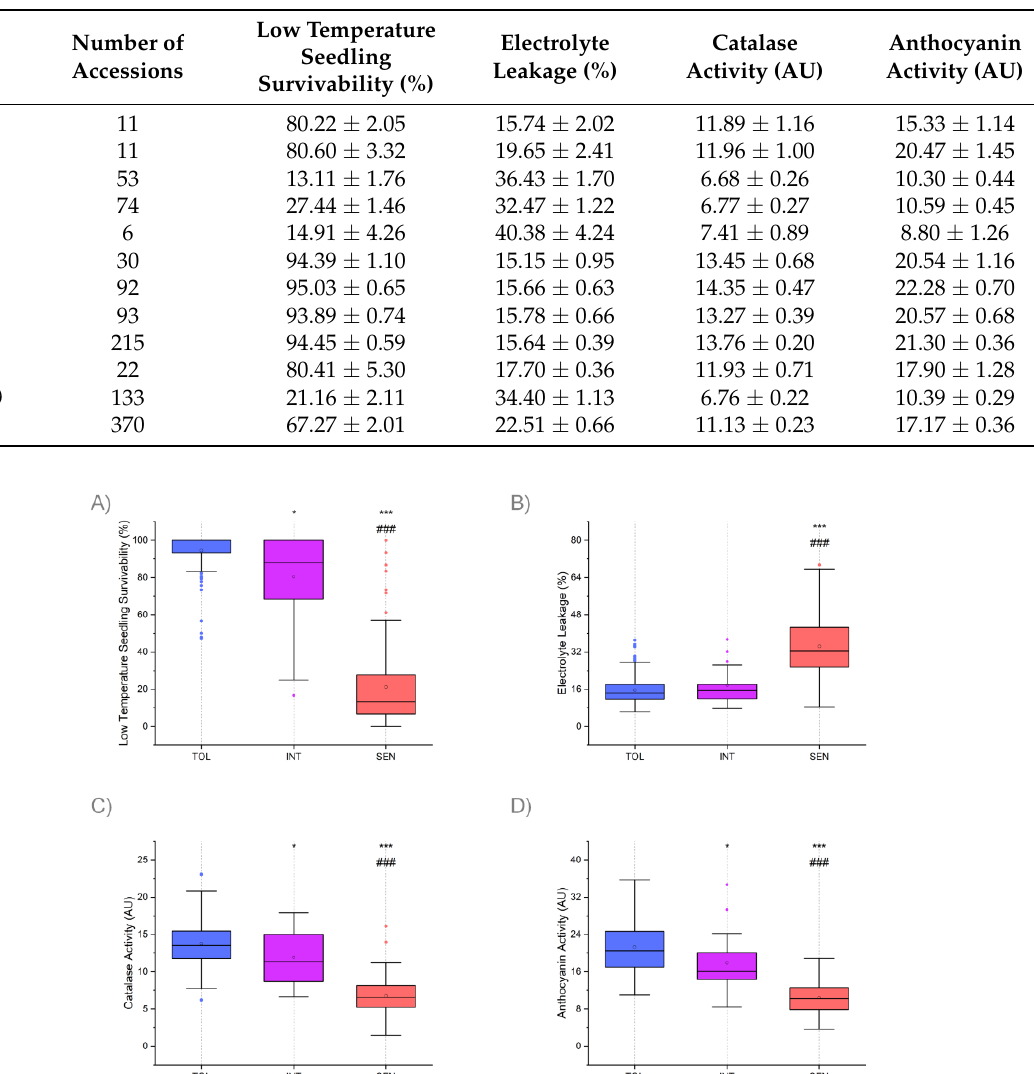
Table 1. Means and standard error for four phenotyping assays using 370 RDP1 O. sativa accessions after a 7-day-10 ◦ C chilling treatment. ARO: aromatic ; AUS: aus ; IND: indica ; MIX-I: admixed accessions within INDICA ; MIX-J: admixed accessions within JAPONICA ; TEJ: temperate japonica ; TRJ: tropical japonica ; TOL: Cold Tolerant; INT: Intermediate Cold Tolerant; SEN: Cold Sensitive.